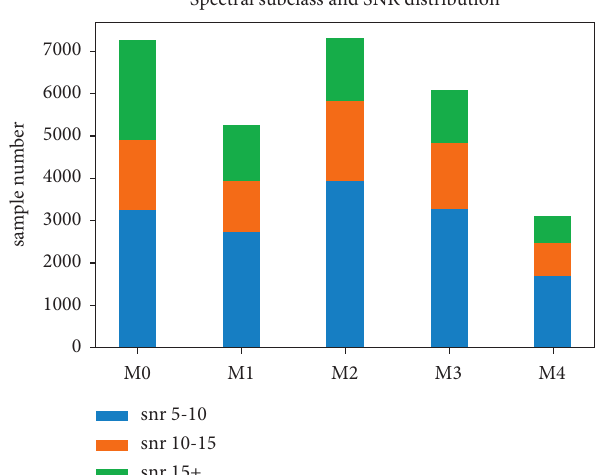
Figure 1: Spectral subclass and SNR